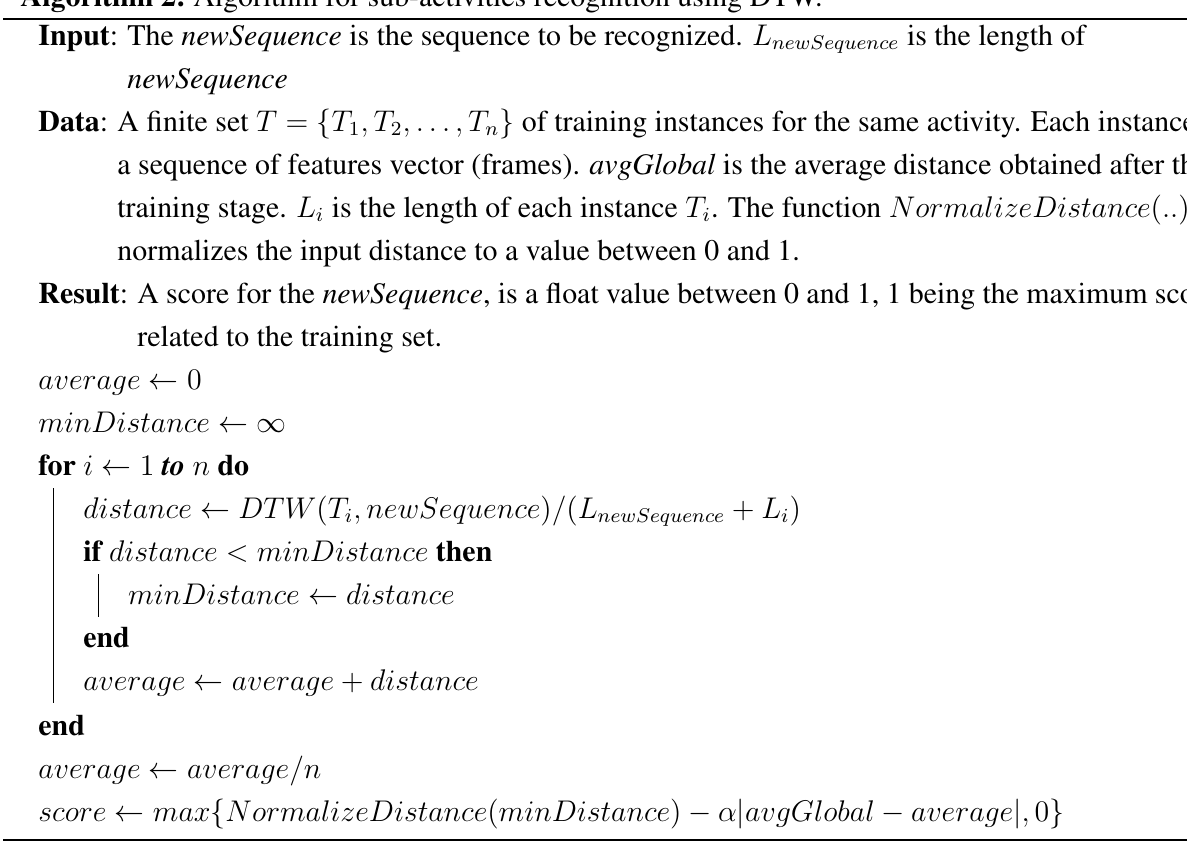
Algorithm 2: Algorithm for sub-activities recognition using